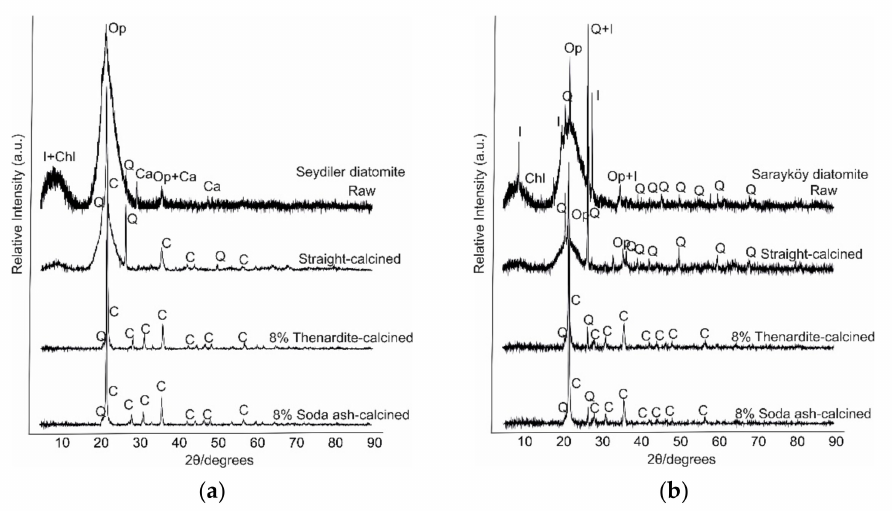
Figure 4. XRD patterns of ( a ) Seydiler diatomite and ( b ) Sarayköy diatomite samples. Op: opal- A/opal-CT, Q: quartz, C: cristobalite, Ca: calcite, I: illite, Chl: chlorite.